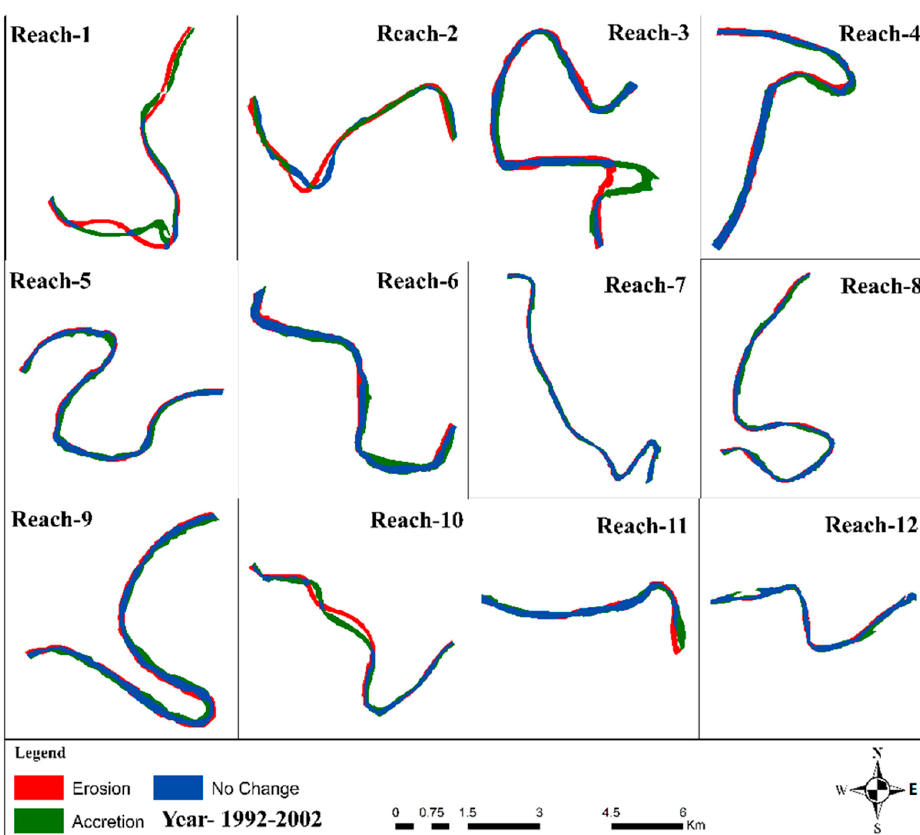
Figure 7. Erosion, accretion, and unchanged area 1992–2002.